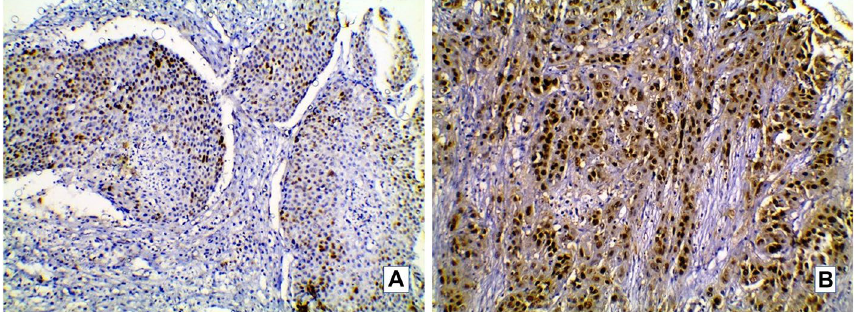
Fig. 3 P53 immunostain in studied MIBC cases. A : Urothelial carcinoma showing p53 wild type staining score ( carcinoma with squamous differentiation showing mutant p53 staining pattern